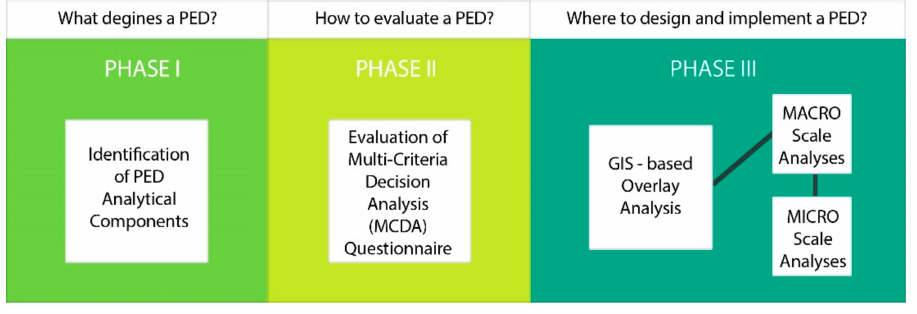
Figure 1. Phases of methodology for identifying PED concept boundary in